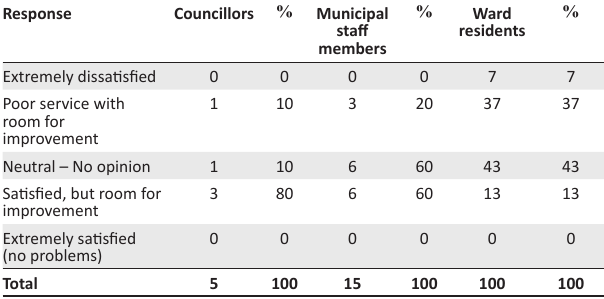
TABLE 5: Summary of the level of satisfaction of the respondents on municipal services.